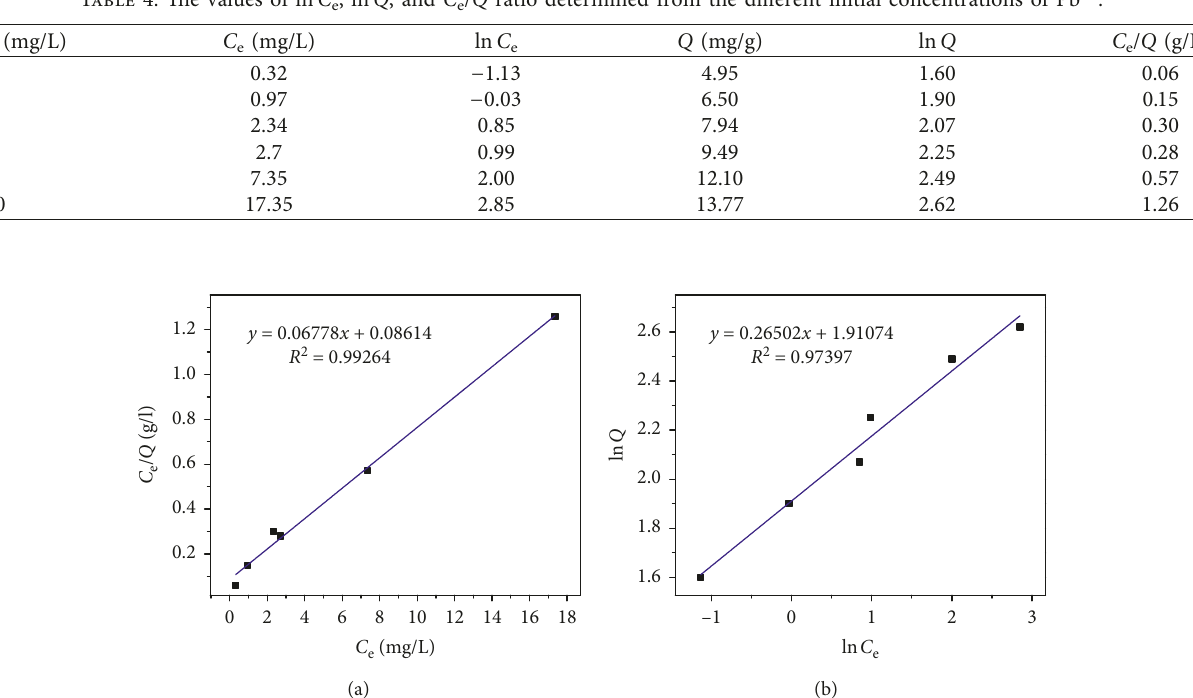
Figure 13: Adsorption isotherm curves at 30 ° C follow (a) Langmuir and (b) Freundlich models.